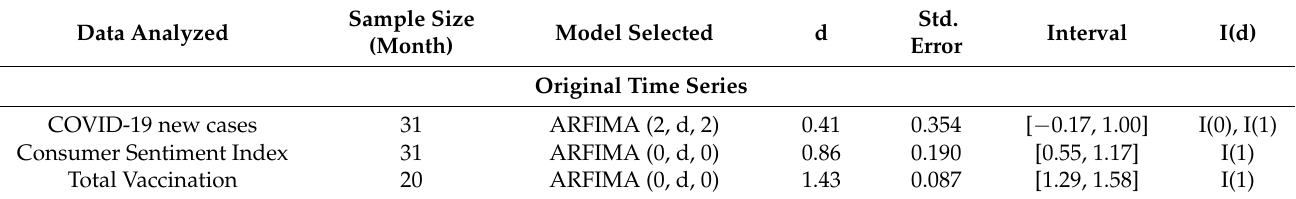
Table 3. Results of long memory